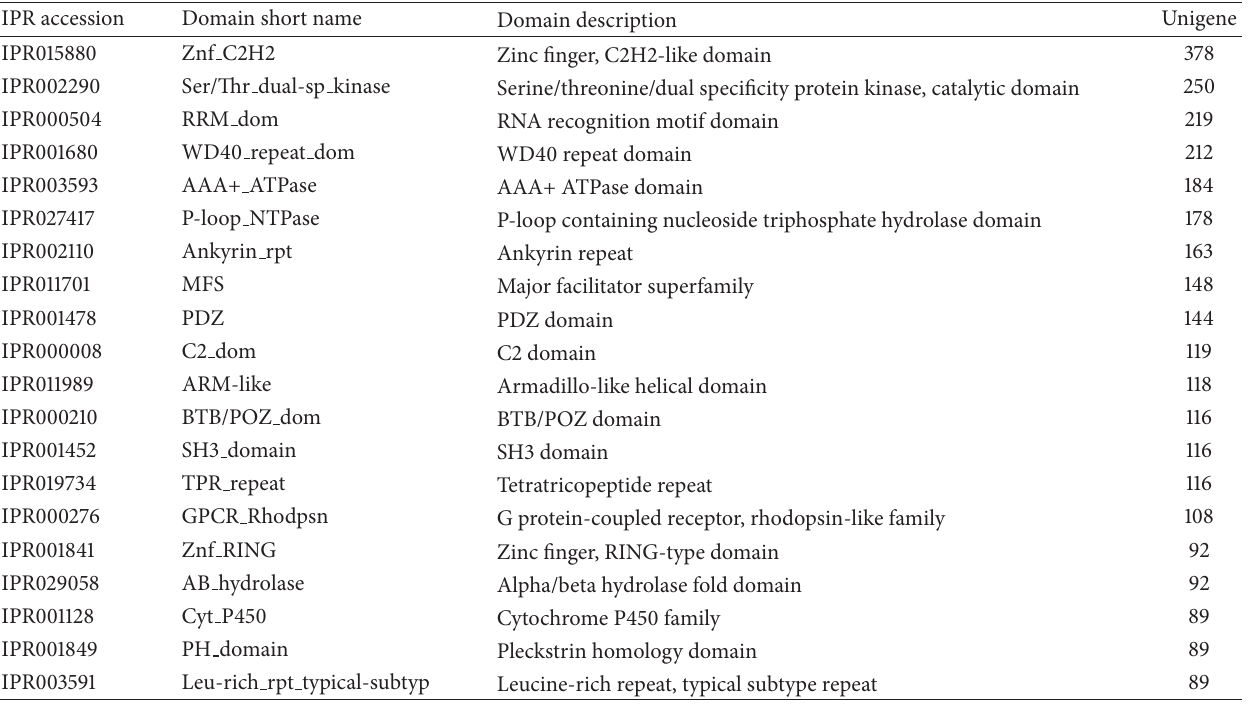
Table 4: Summary of top 20 domains predicted in V. mandarinia unigene